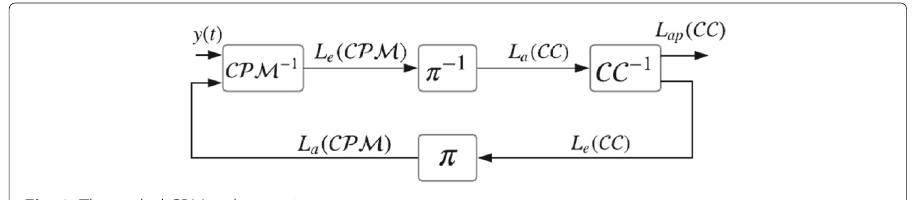
Fig. 3 The coded CPM turbo